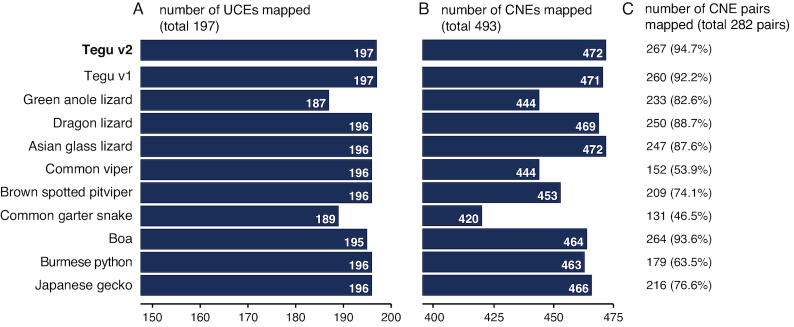
Using conserved non-coding elements to compare genome completeness and contiguity. Bar charts show (A) the number of aligning UCEs that do not overlap coding regions (N = 197 in total) and (B) the number of aligning CNEs that do not overlap exons (N = 493 in total). (C) The percentage of 282 evolutionarily conserved pairs of neighboring CNEs that are also found as neighbors in the squamate assemblies. Both UCE and CNE sets are highly conserved among vertebrates and thus are likely to exist in squamates.